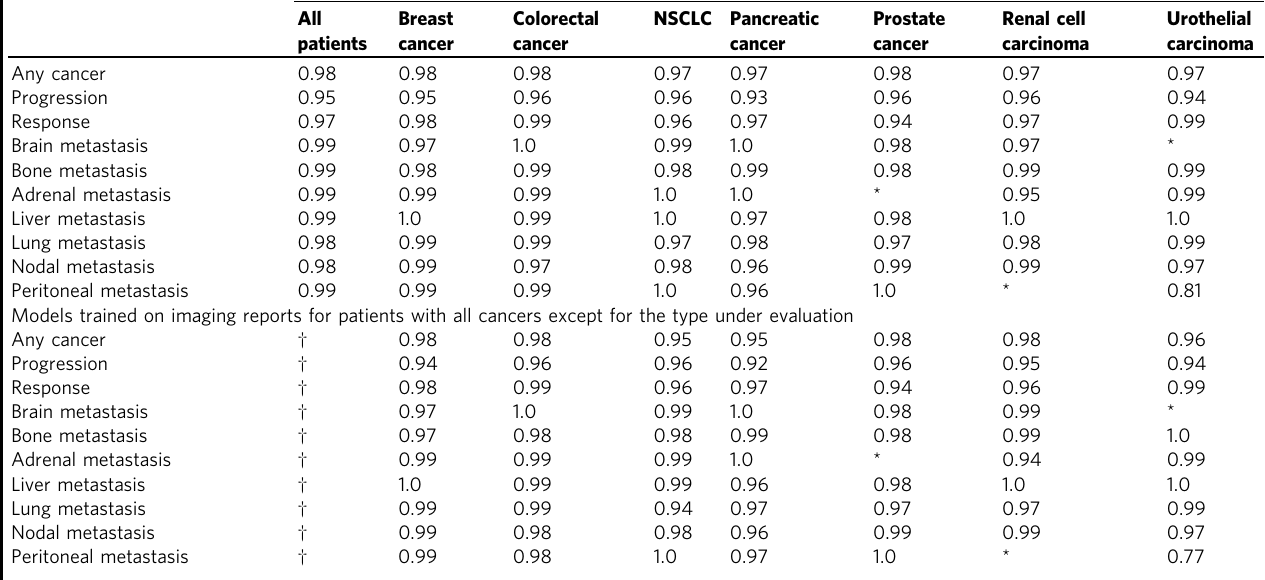
Table 3 Areas under the receiver operating characteristic curve (AUROCs) for NLP models that interpret imaging report text to ascertain clinical outcomes, as evaluated in the labeled test set. Clinical outcome Models trained on imaging reports for patients with all listed cancer types All